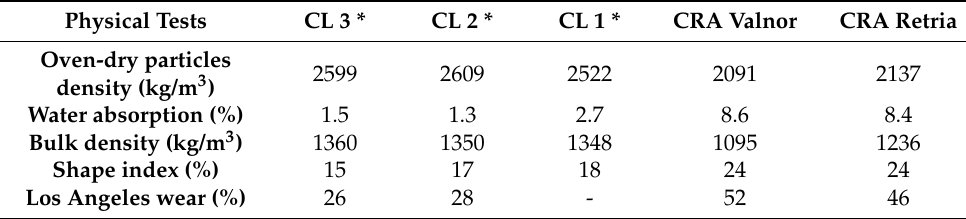
Table 2. Results of the physical tests of the coarse